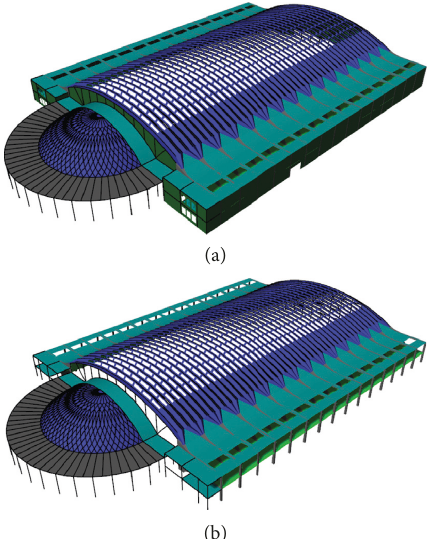
Figure 6: Geometrical model of Hall B with infill walls (a) and in its damaged configuration (b).